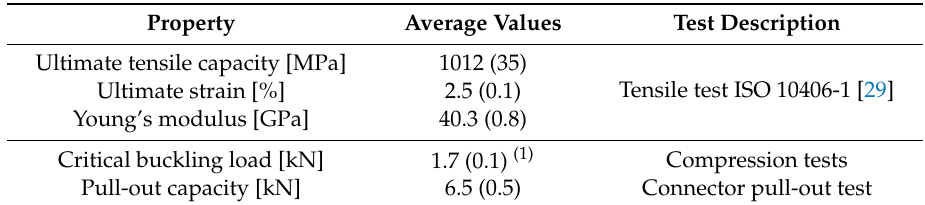
Table 2. Average properties for GFRP connectors (standard deviation in parenthesis), source: [22].